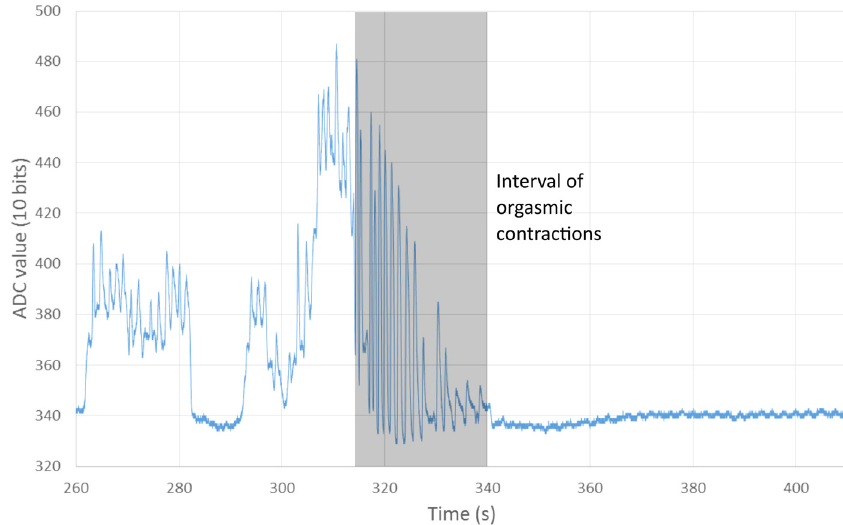
Figure 32: Anal sphincter tension recorded during masturbation and orgasm.